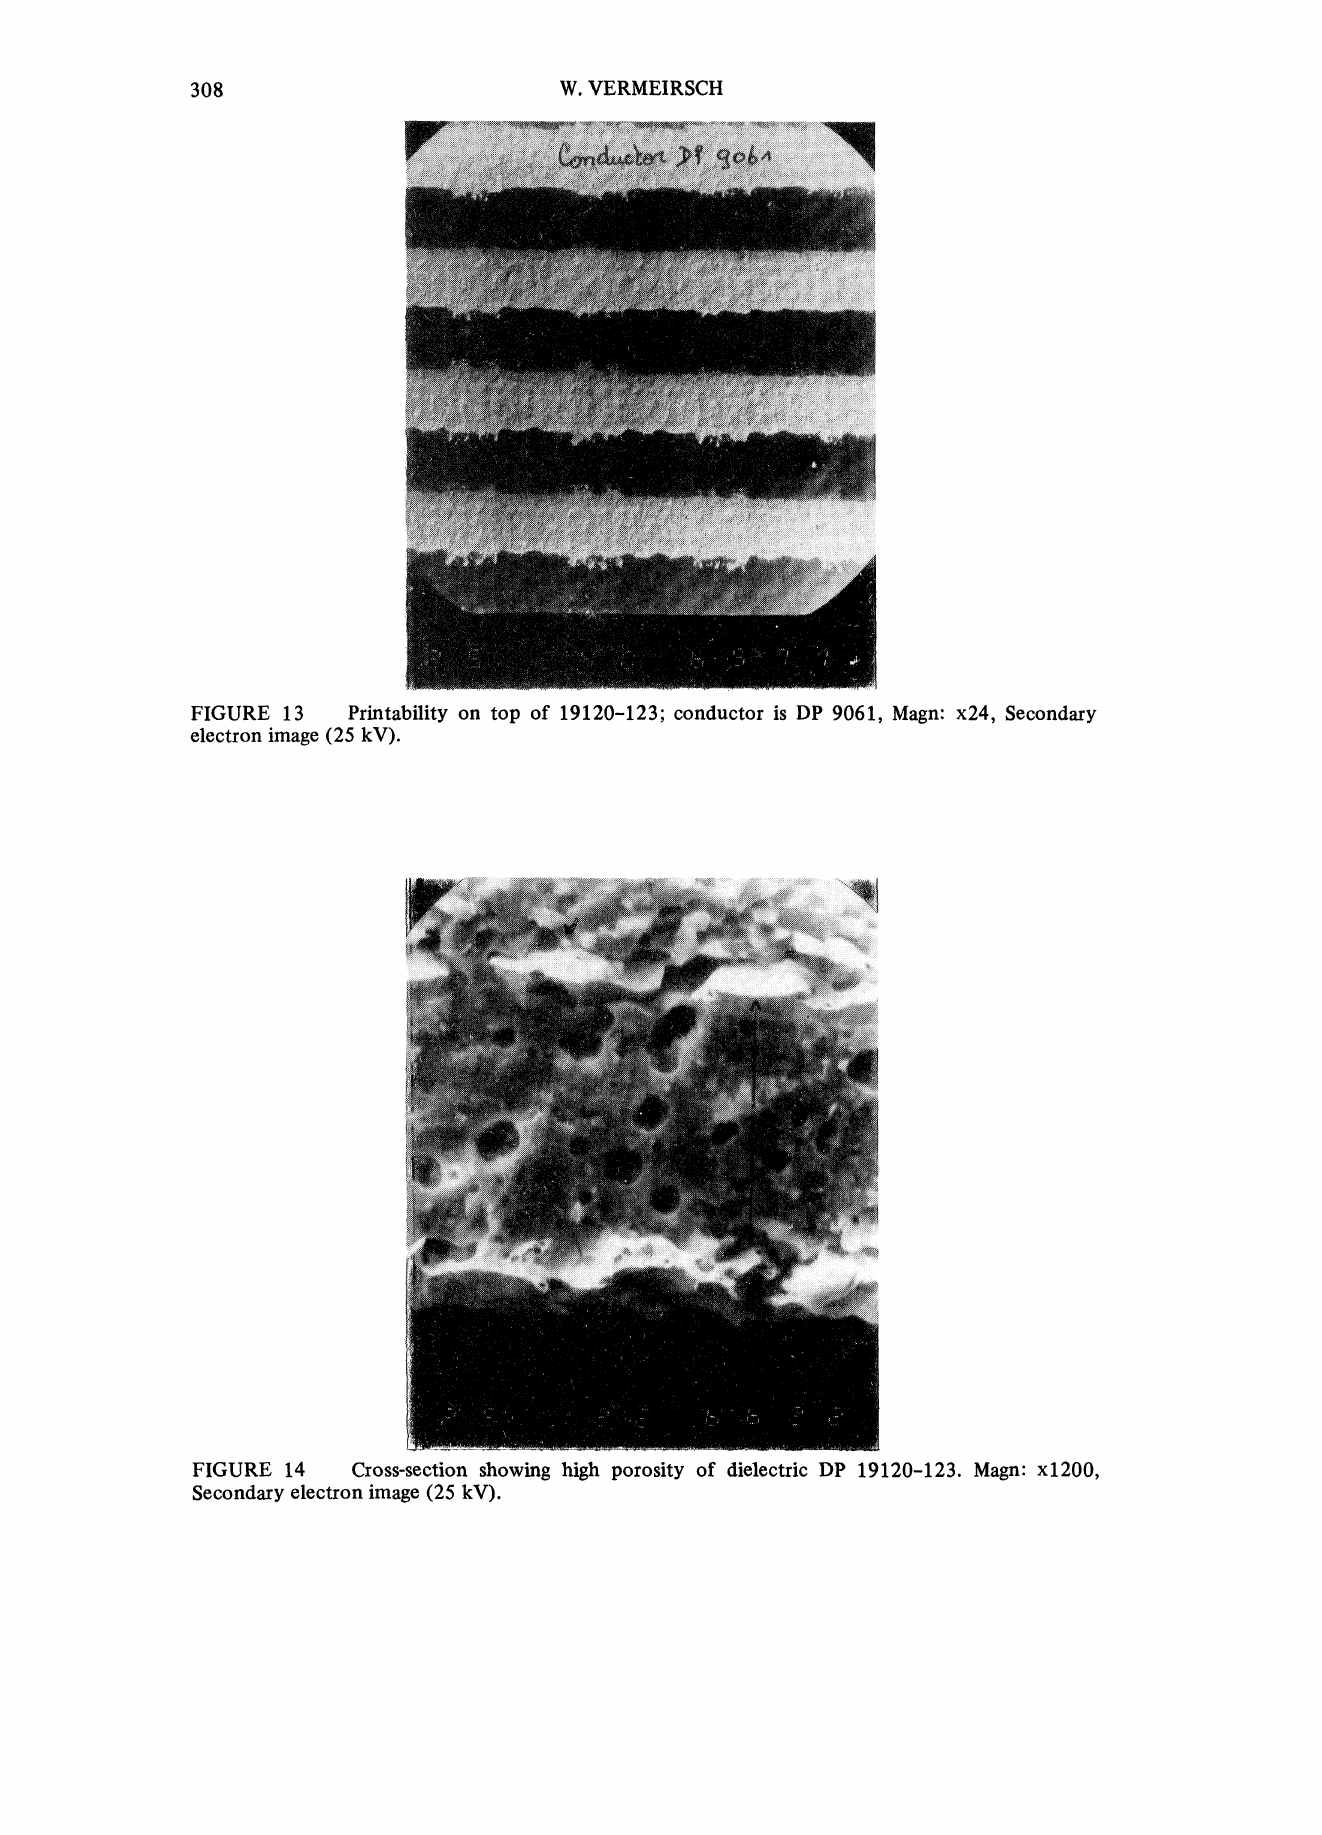
FIGURE 14 Cross-section showing high porosity of dielectric DP 19120-123. Magn: x1200, Secondary electron image (25